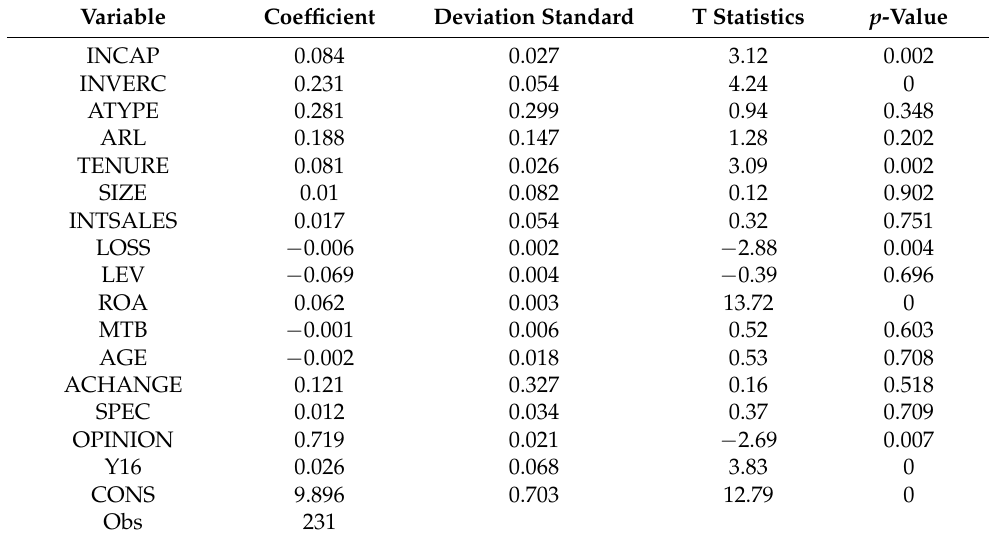
Table 6. The results of estimating the first model by the OLS method.